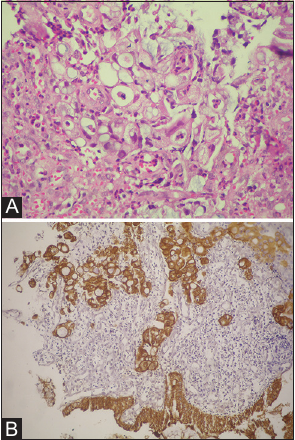
FIGURE 2. (A) Glands that show prominent cytological atypia within inflammatory exudate and the histopathological exam - ination findings observed with regenerative epithelial change (Hematoxylin-eosin staining; x 40). (B) The immunohistochemical examination with